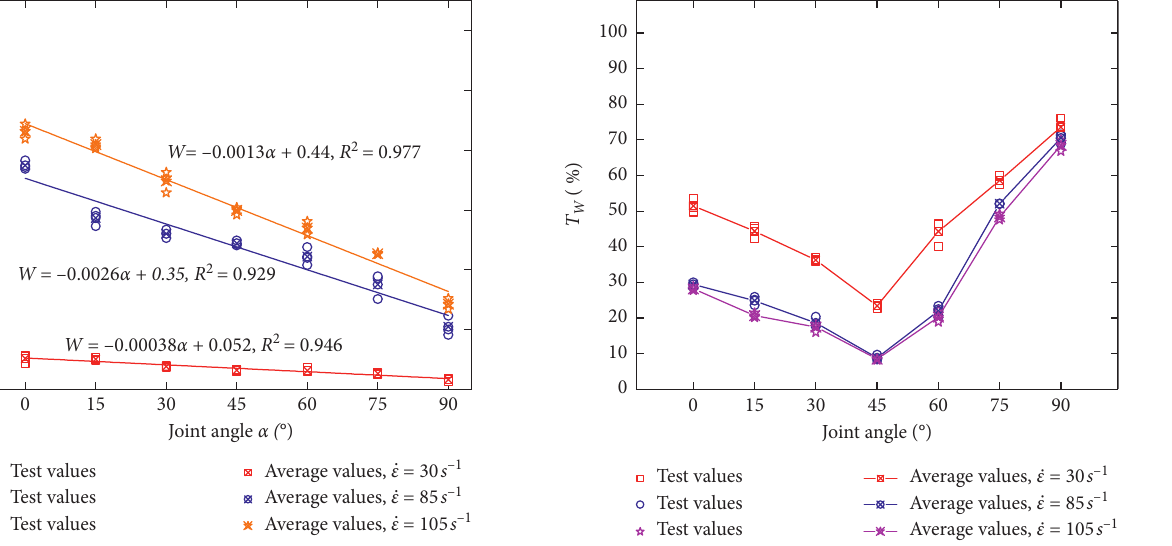
W with joint angle under three different